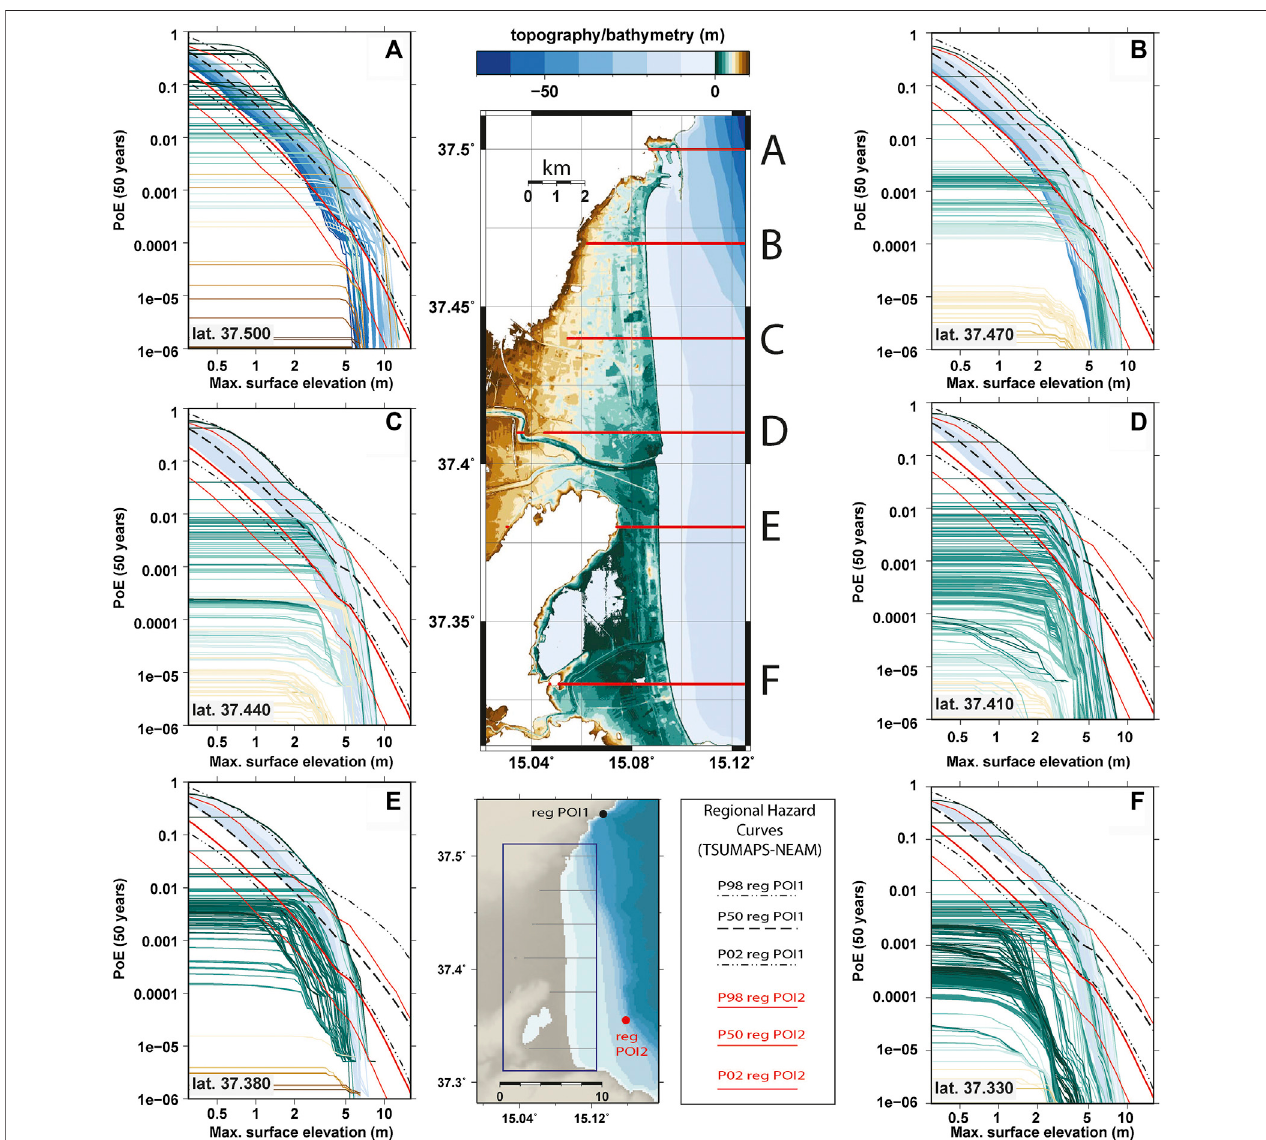
FIGURE11| Comparison ofsurfaceelevation (MIHonshore)betweenlocal and regionalassessments.The red and black lines indicate percentilesasindicated for MIH estimated from offshore heights using ampli fi cation factors (Glimsdal et al., 2019) and the local hazard curves are displayed for every grid node along the transects indicated.Colorsindicatethetopographicelevationofthepointasindicated:bluelinesareoffshore,greenlinesarelowelevationonshore,andbrownlinesindicatehigher elevations. Since we display maximum surface elevation (relative to the baseline sea level), and not fl ow depth, the hazard curve is fl at until it reaches the local topographic height and only starts to be meaningful at values greater than this. Further details are provided in the text.